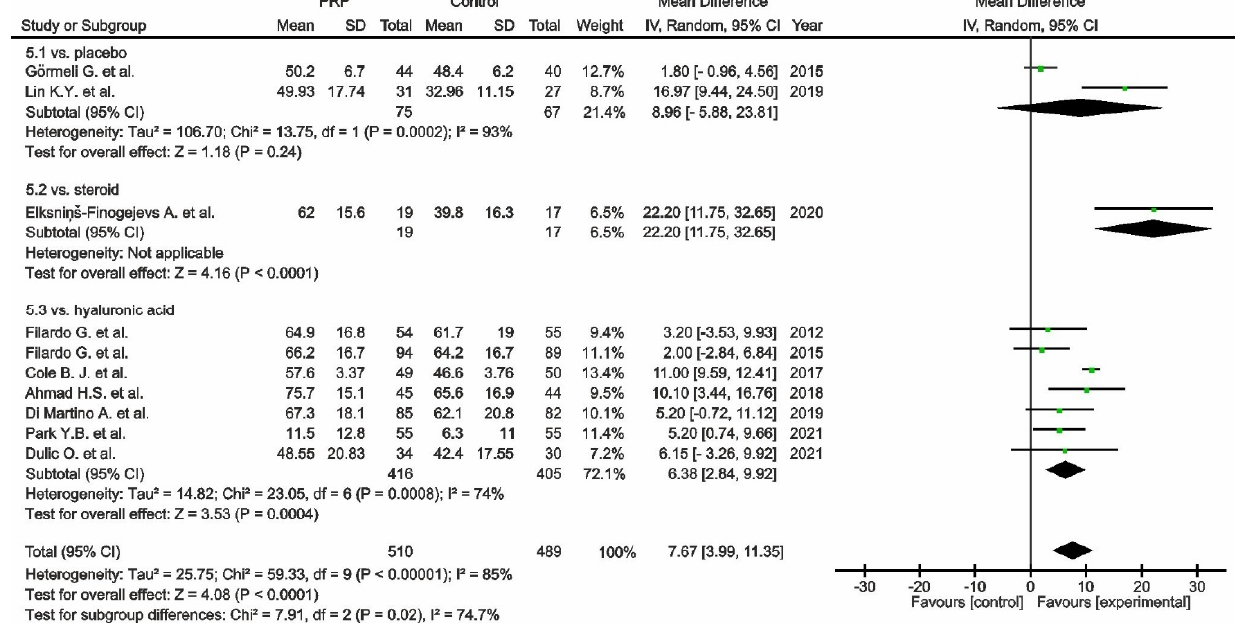
Figure 6. Forest plot for KOOS sub-scores (ADL, activities of daily living; CI, confidence interval; IV, inverse variance; QoL, quality of life; SD, standard deviation; , mean with 95% confidence interval for total and subtotals; , mean with 95% confidence interval for source data ).